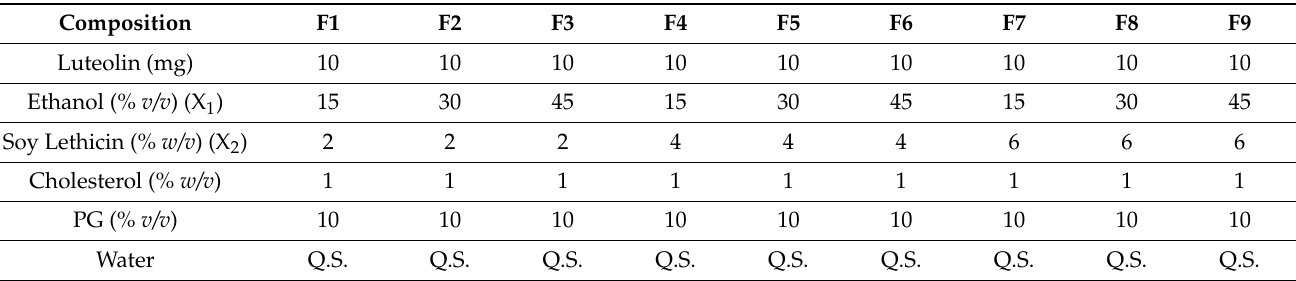
Table 1. Composition of different LUT-ENPs